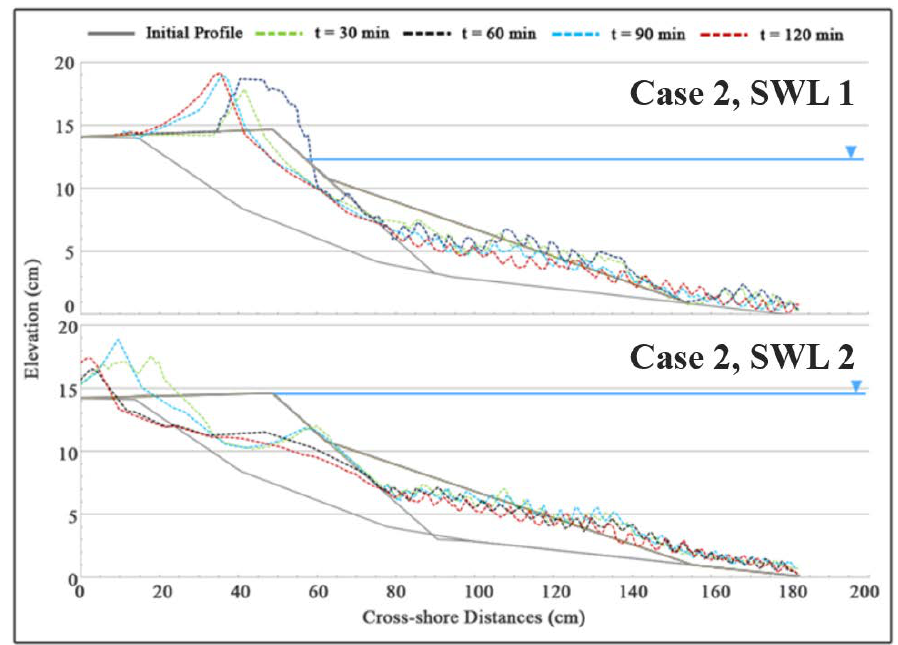
Figure 7. Case 2 with SWL 1 and SWL 2 profile evolution of t 1 , t 2 , t 3 , and t 4 .